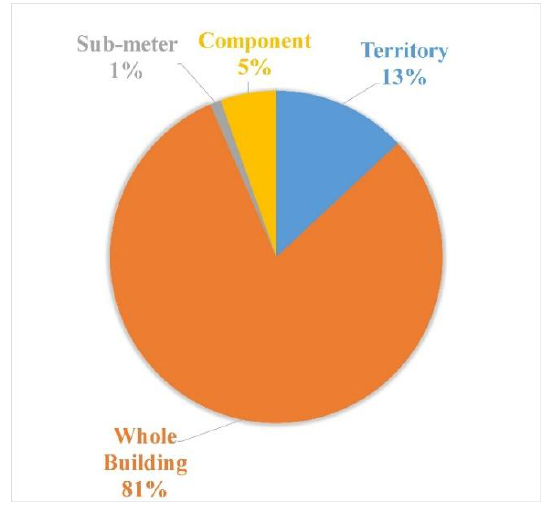
Figure 7. Application levels of applied ANN forecasting models.